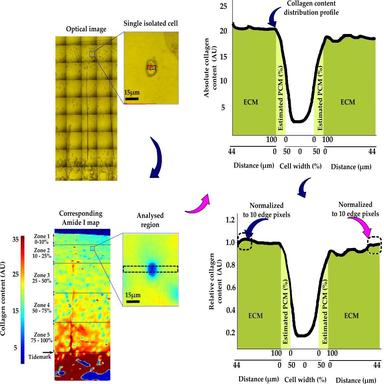
Single isolated chondrocytes were located with the light microscope attached to the FTIR-MS device and HR-FTIR-MS imaging was performed for the selected region around cells. The borders of the cell were estimated from the optical image (see also Fig. 3) and the analyzed horizontal region of interest (ROI) extended 40 pixels (∼44 μm) towards the extracellular matrix from both ends (left and right) of the estimated PCM. The PCM was then interpolated to 5 pixels, and cell to 15 pixels, to allow point-by-point